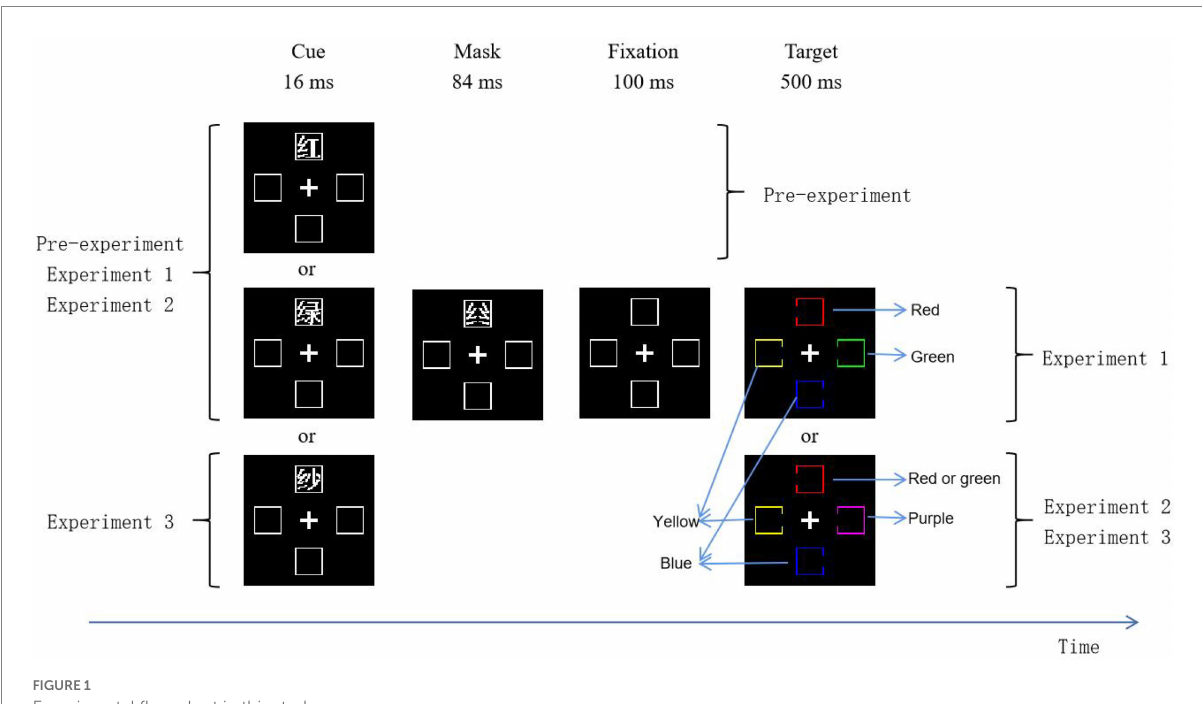
FIGURE 1 Experimental flow chart in this